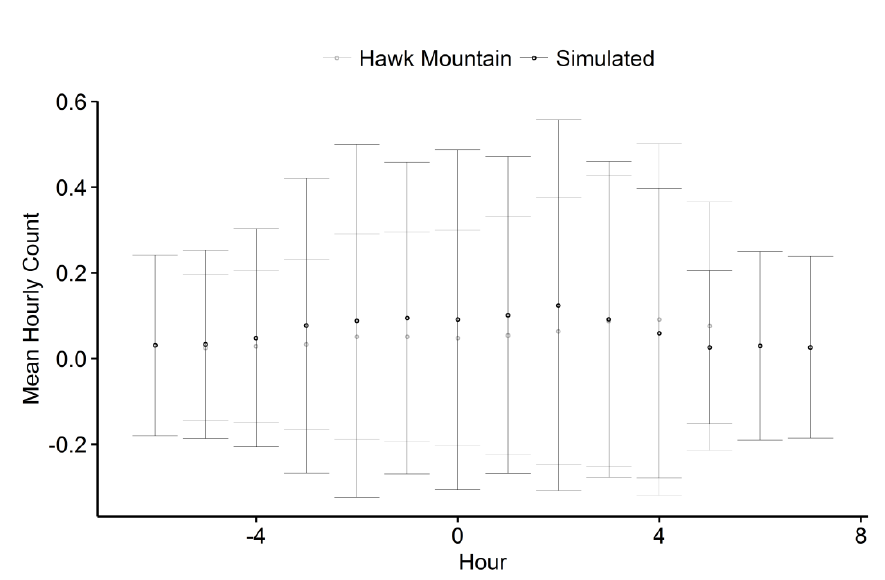
Figure A3.5. Comparison of mean (SD) raptor migration count by hour of the day between data collected at Hawk Mountain, Pennsylvania (1966-2010) and simulated data (20 years), for a rarely detected species (Peregrine